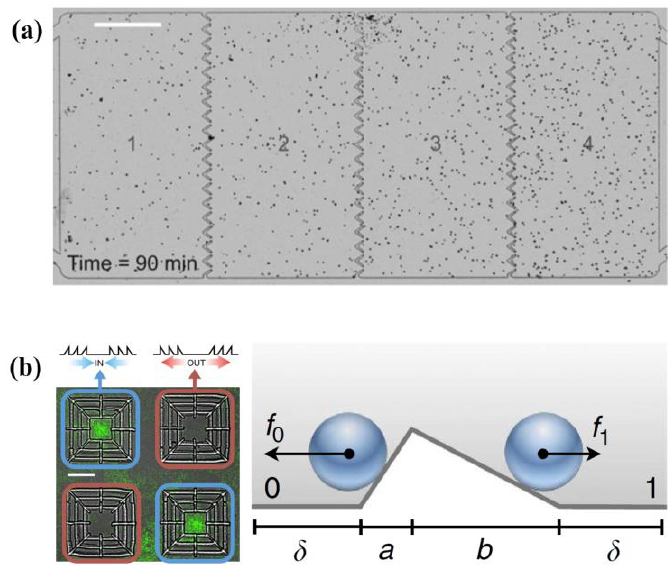
Figure 5. Particles transport and separation mediated by bacterium-based NMMs. ( a ) Funnel- shaped wall used to rectify the bacteria flow. Scale bar, 0.5 mm. Reprinted with permission from Reference [62], Copyright 2013, National Academy of Sciences. ( b ) Particles concentration and depletion driven by bacteria and the schematic of active particles crossing an asymmetric barrier. Scale bar, 20 µ m. Reprinted with permission from Reference [12], Copyright 2013, Springer Nature.